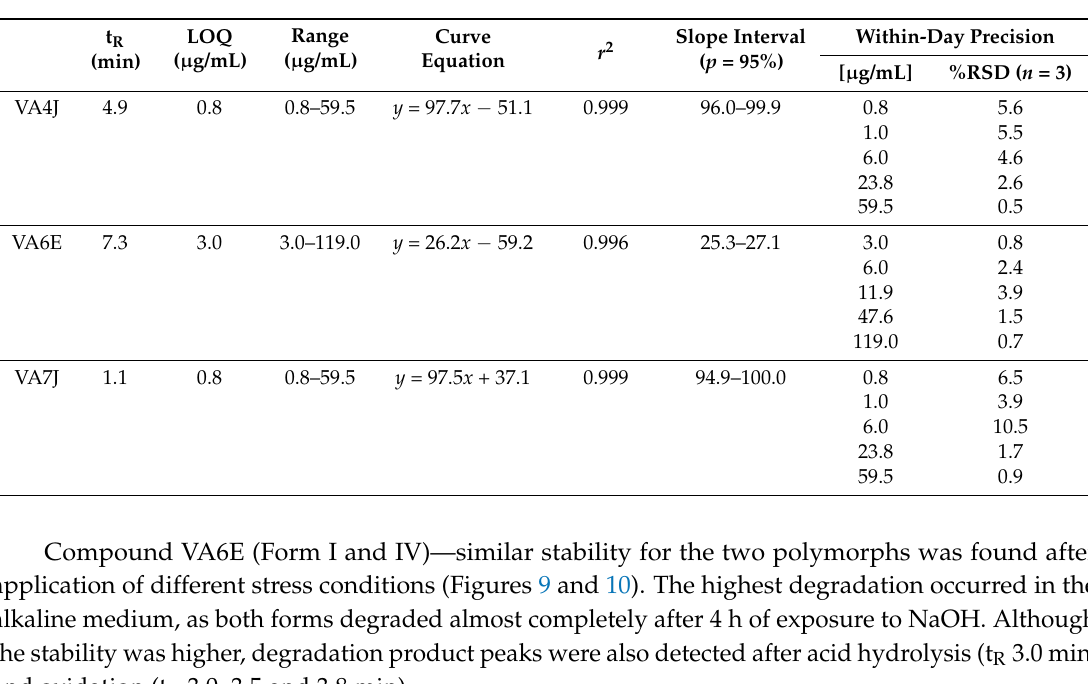
Table 6. Limit of Quantification (LOQ), linearity data and within-day precision.